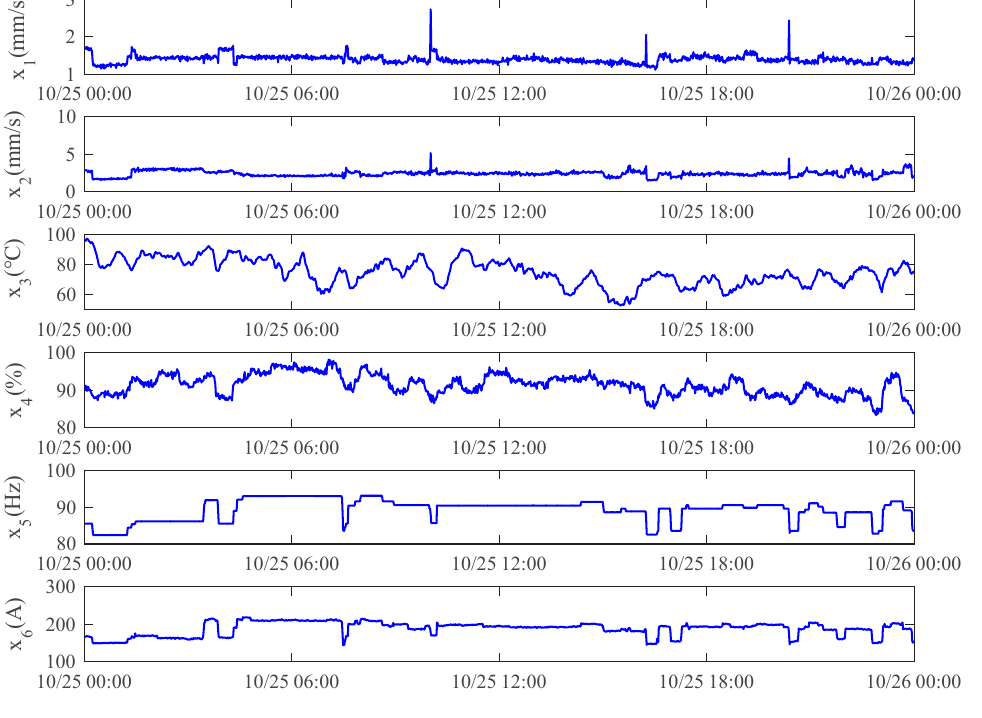
Figure 4. Layout of variables data.